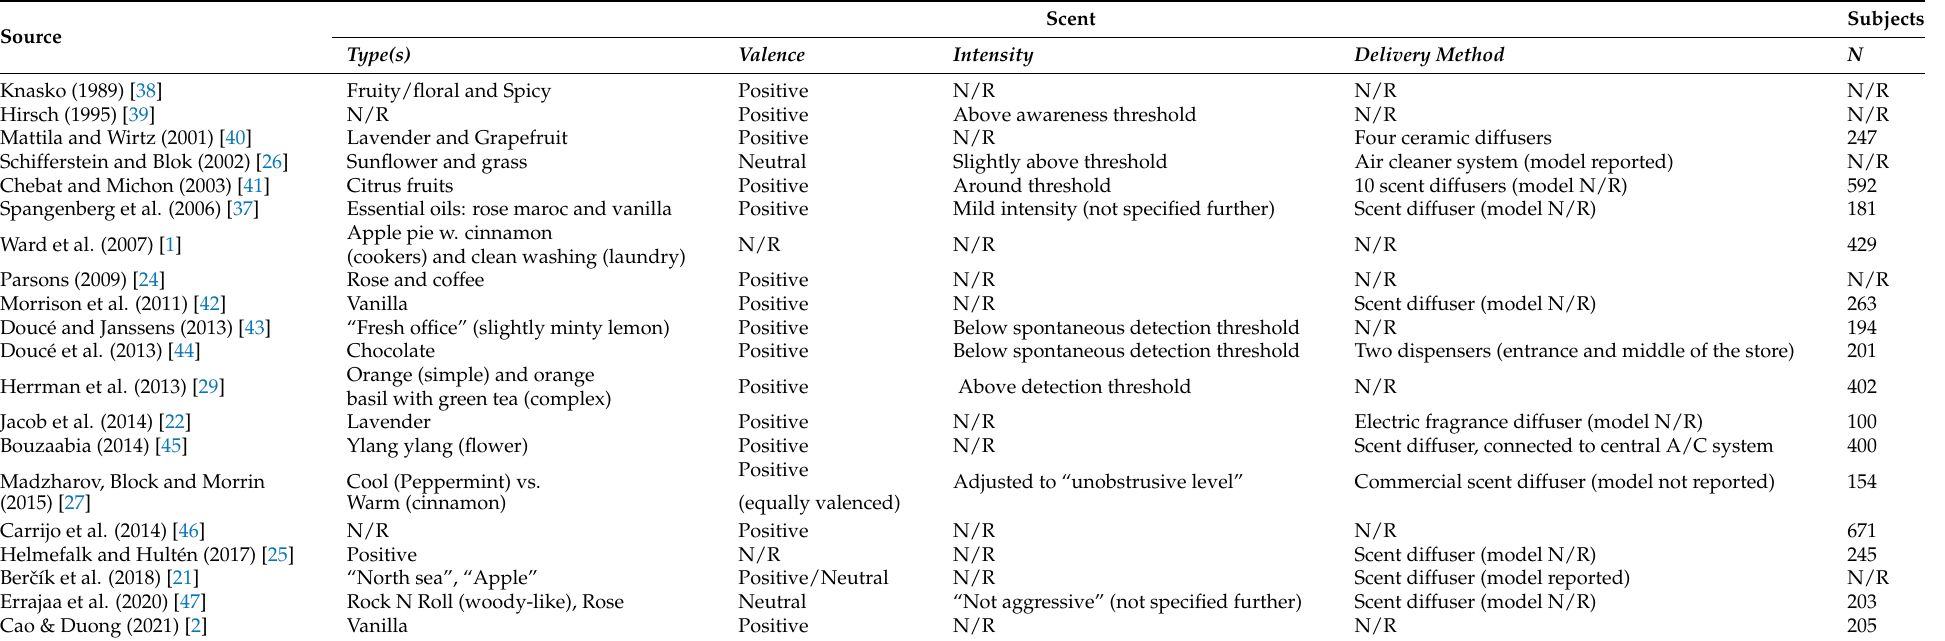
Table 2. Experimental conditions in the reviewed literature. N/R = not